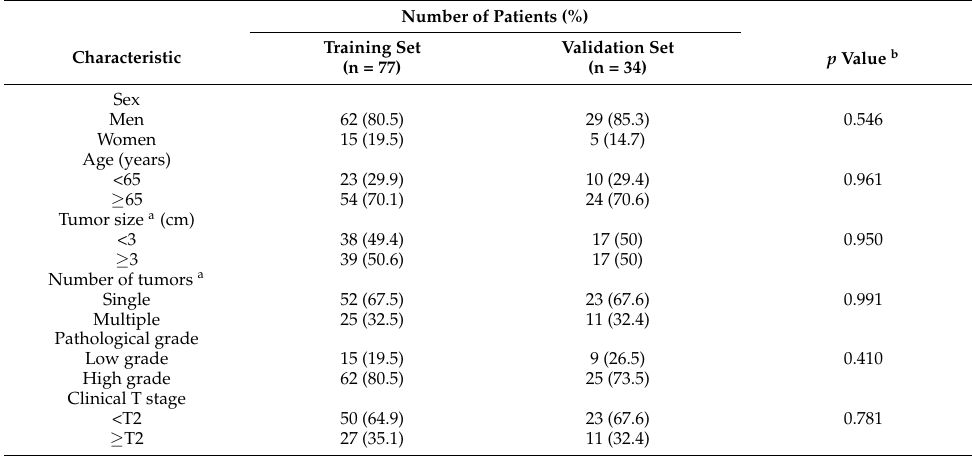
Table 1. Clinicopathological characteristics of patients in our center.